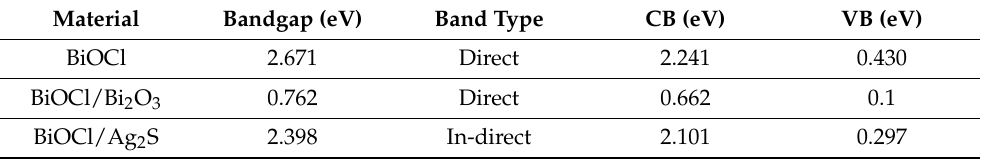
Table 2. CB and VB for BiOCl, BiOCl/Bi 2 O 3 , and BiOCl/Ag 2 S.